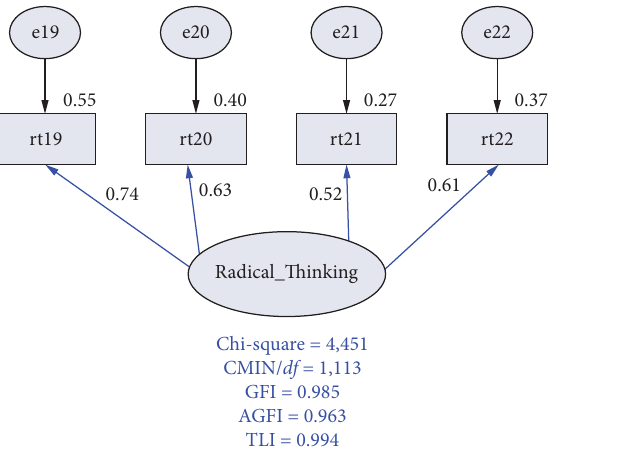
F IGURE 5: Diagram and output of AMOS 24 application for radical thinking dimension.